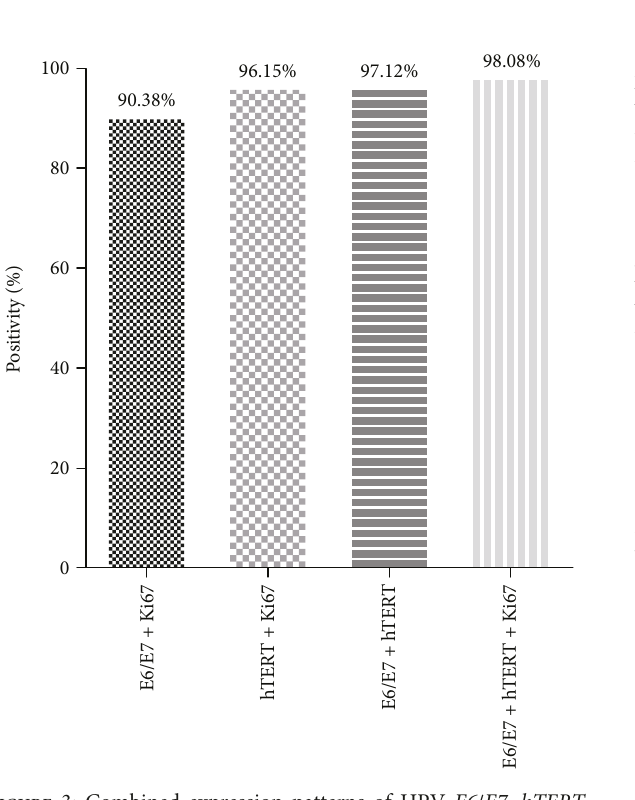
Figure 3: Combined expression patterns of HPV E6/E7 , hTERT , and Ki67 mRNA in high-grade squamous intraepithelial lesion (HSIL) clinical samples. All of HSIL group could not identify with one marker; therefore, combinational detection of multiple target was tried. Combination of HPV E6/E7 , hTERT , and Ki67 showed 98.08% (102/104)